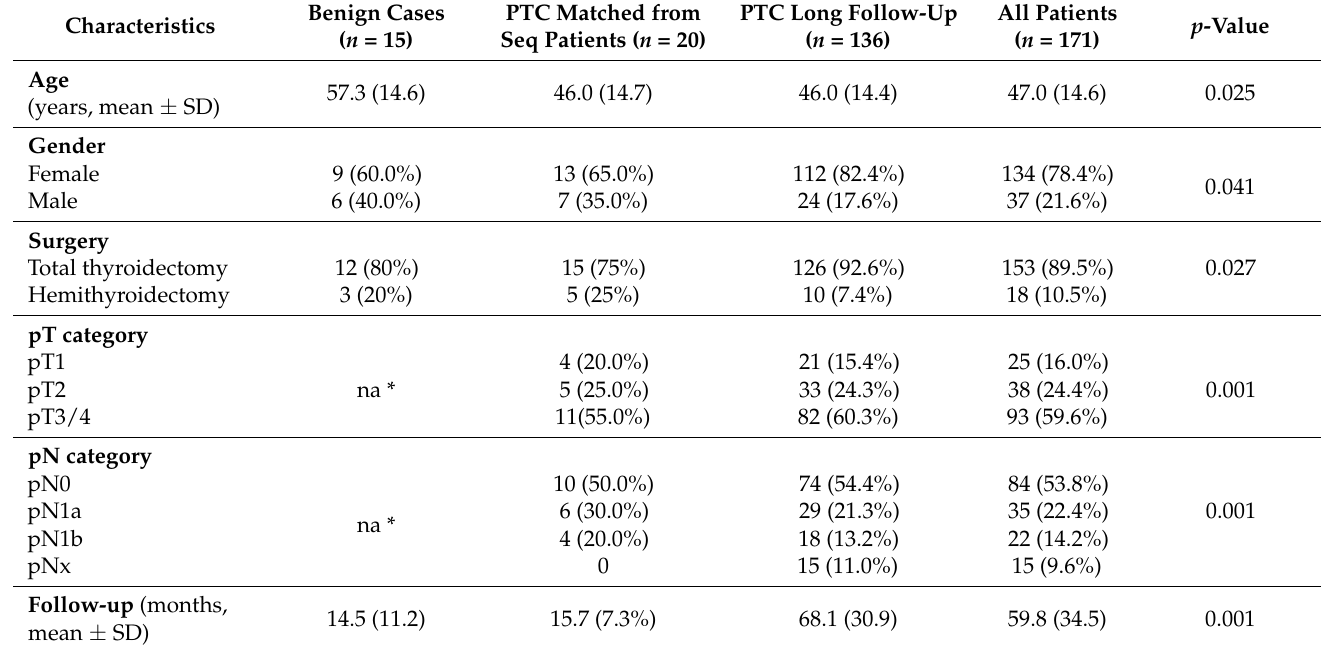
Table 4. Clinicopathological characteristics of the validation cohort from the PTC